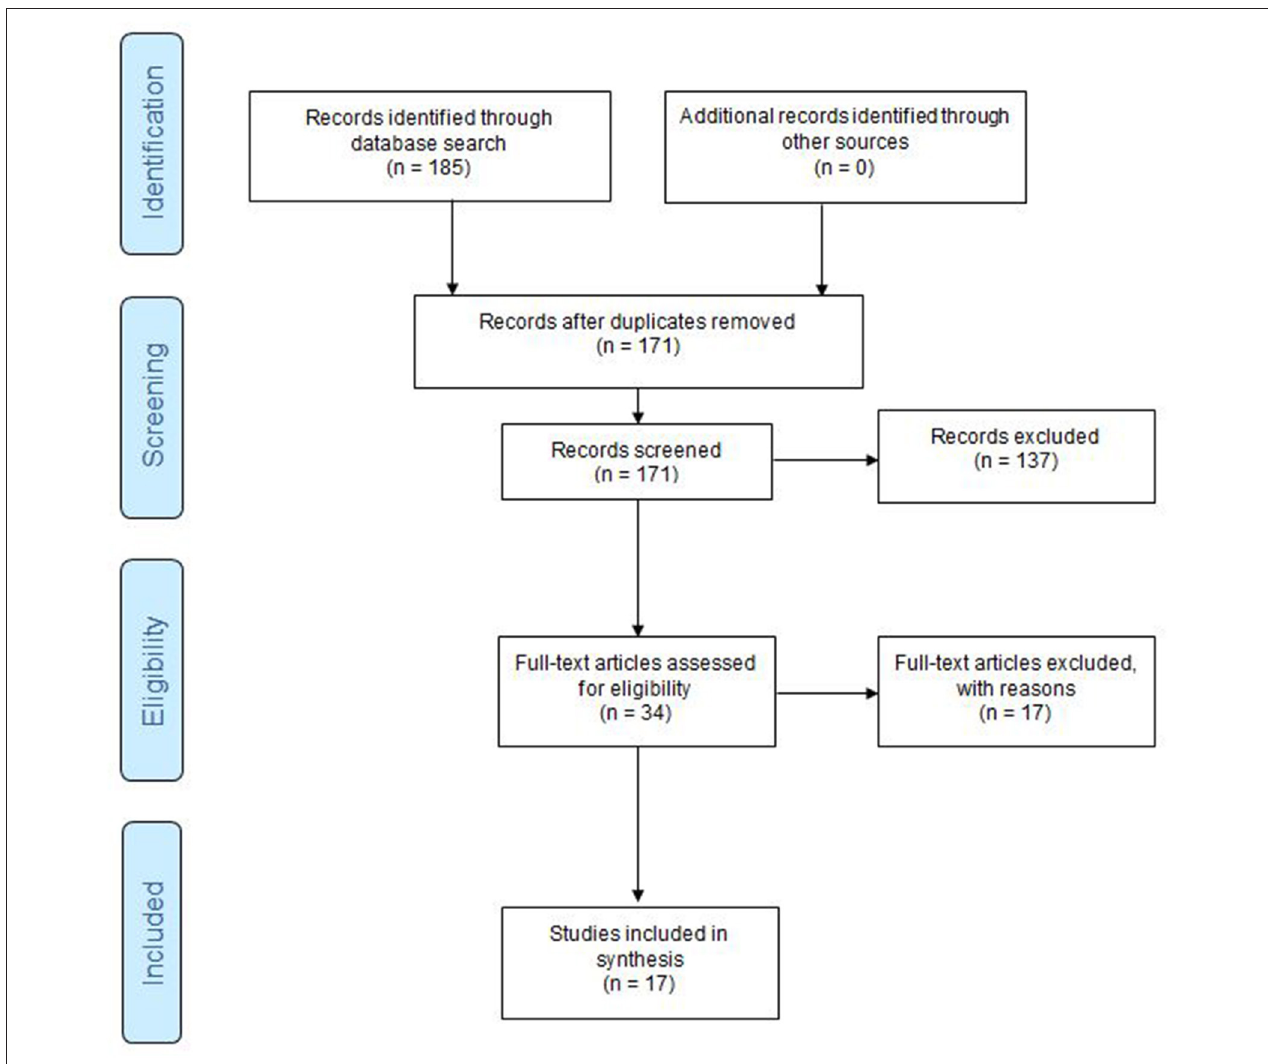
FIGURE 1 | PRISMA P Flow Diagram of abstract screening and full text extraction process. Flow Diagram adopted from Moher et al.